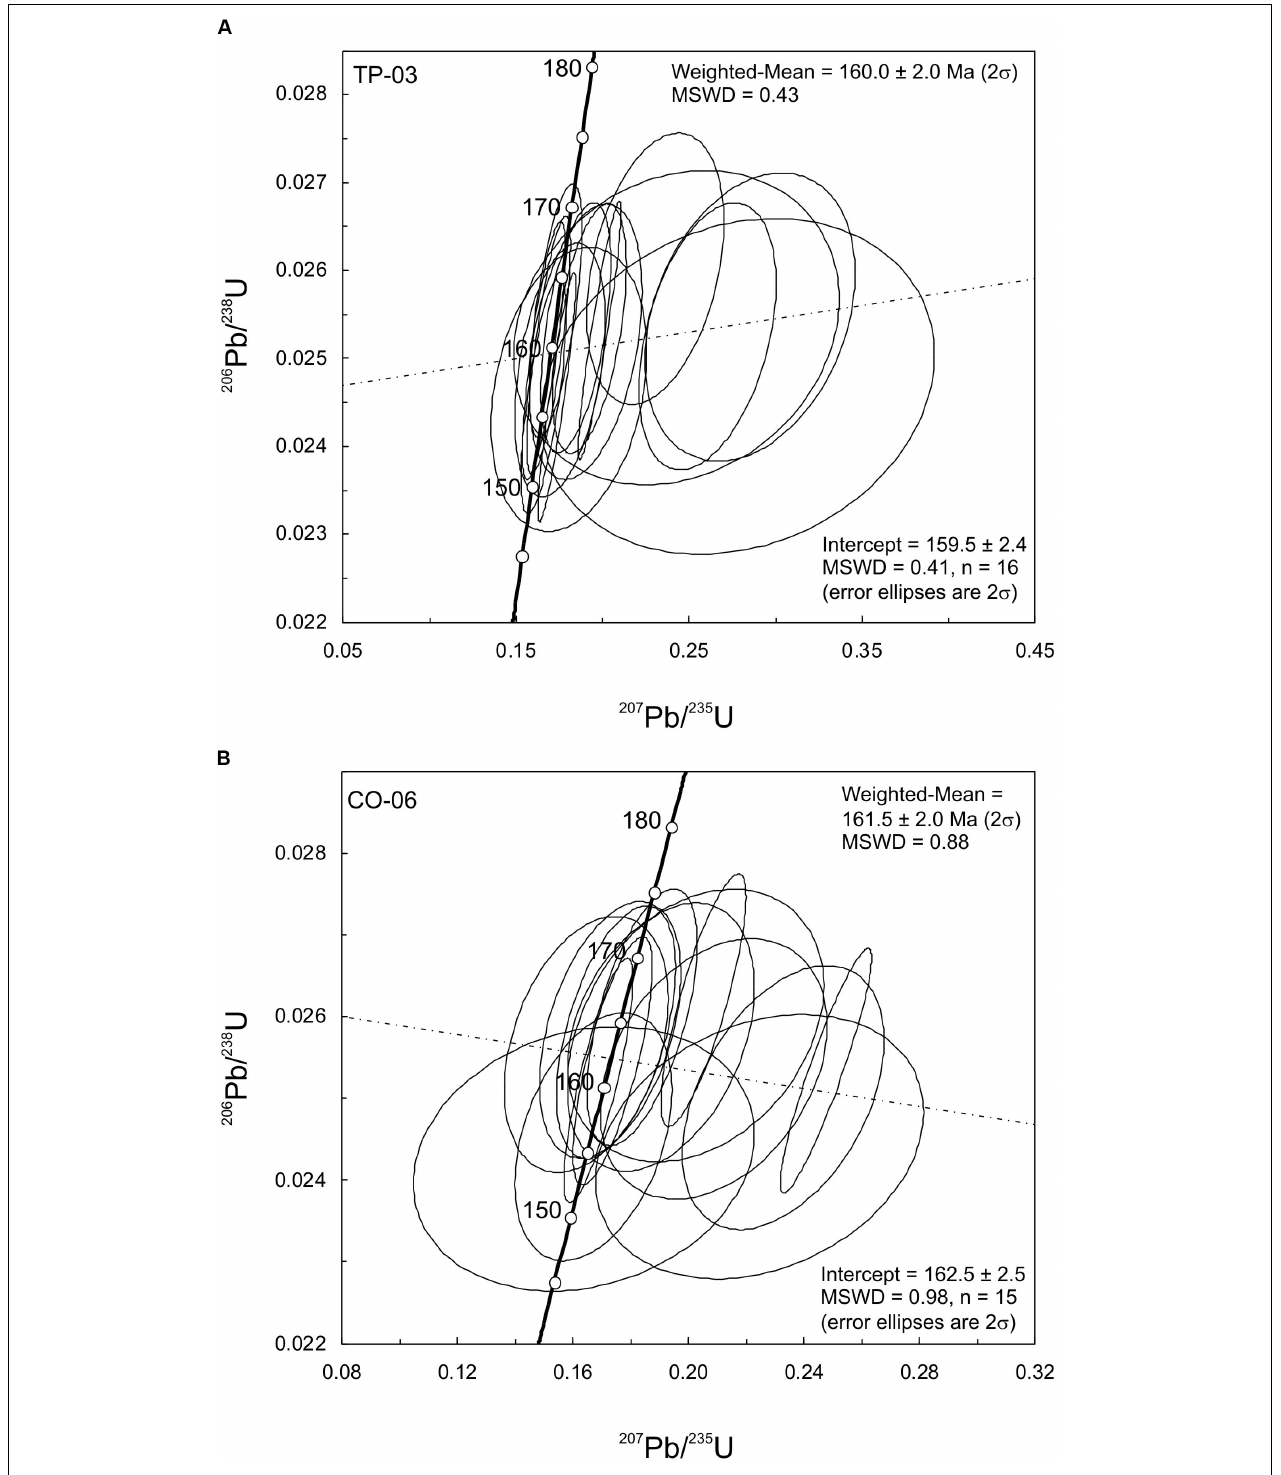
FIGURE 3 | (A) Concordia diagram with the weighted-mean age of zircon U-Pb data from TP-03. (B) Concordia diagram with the weighted-mean age of zircon U-Pb data from CO-06.